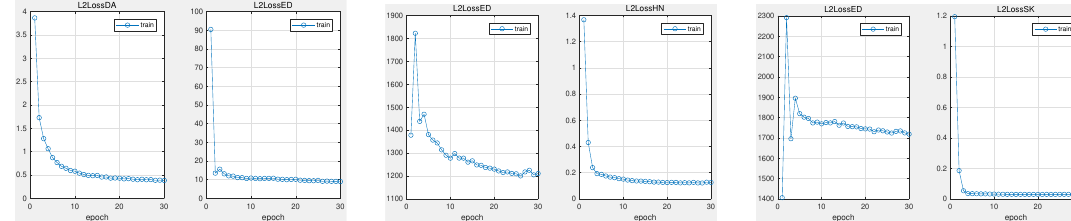
Figure 11. Training progress on different data-imbalance schemes. Each pair illustrates strategy loss and real Euclidean loss. With the same training conditions, all scheme losses rapidly converge. However, the HN and SK losses emerge with large displacement in ED loss. The training process actually requires more training epochs to prevent model overfitting. The proposed distractor-aware loss method can converge rapidly without overfitting. Results are best viewed on high-resolution